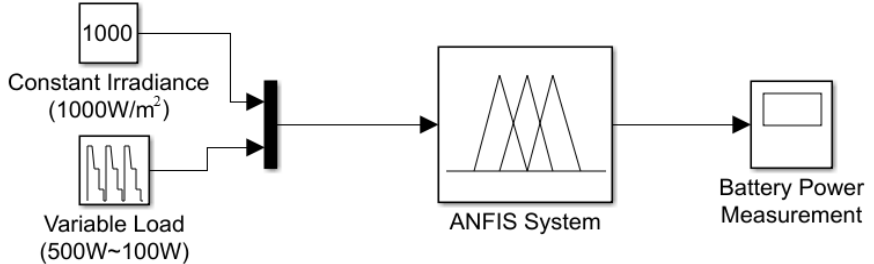
Figure 7. P batt ANFIS model.